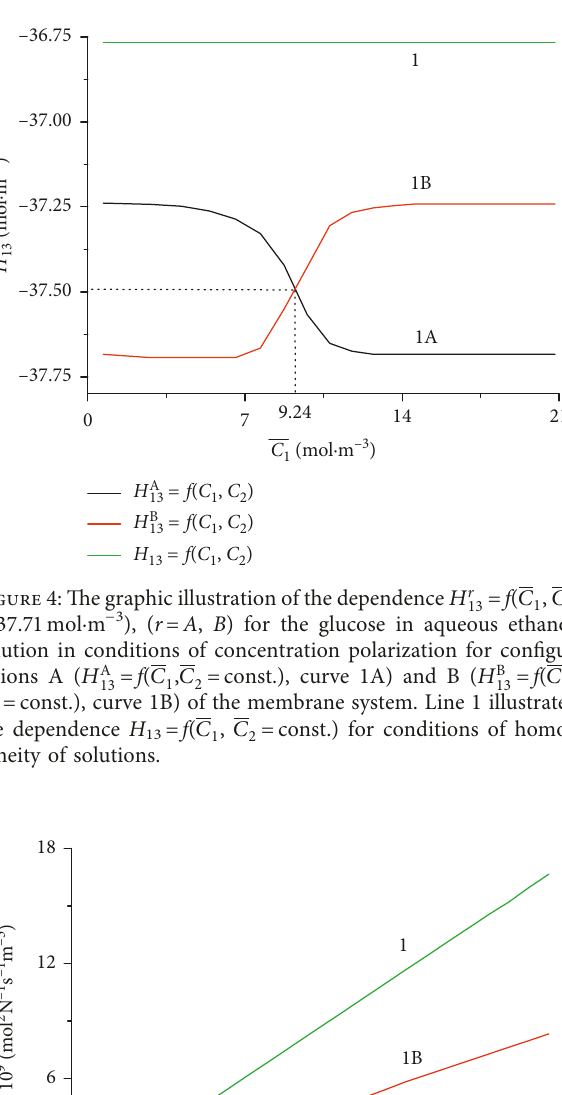
Figure 3: The graphic illustration of the dependence H r C ij (cid:31) f ( 1 , 3 ), ( i C j , r A , B ) for the glucose in aqueous 2 (cid:31) 37.71mol · m (cid:31) ethanol solution in conditions of concentration polarization for Figure 5: The graphic illustration of the dependence H r − configurations A and B of the membrane system, respectively: 3 ) ( r ≠ 37.71mol m A , B ) for the glucose in aqueous ethanol (cid:31) · (cid:31) H A f ( C 1 , C 2 const.)—curve 1A; H B f ( C 1 , C 2 const.)—curve solution in conditions of concentration polarization for configu- 12 (cid:31) 12 (cid:31) (cid:31) (cid:31) − H B f ( C 1 , C 2 const.)—line 2. The lines illustrate 1B; and H A rations A ( H A f ( C 1 , C 2 const.), curve 1A) and B ( H B 21 (cid:31) 21 (cid:31) (cid:31) 22 (cid:31) (cid:31) the dependence H 12 f ( C 1 , C 2 const.)—line 1 and H 21 f ( C 1 , C (cid:31) (cid:31) (cid:31) 2 (cid:31) const.), curve 1B) of the membrane system. Line 1 illustrates C f ( C 1 , C 2 const.) in conditions of homo- the dependence H 22 (cid:31) (cid:31) geneity of